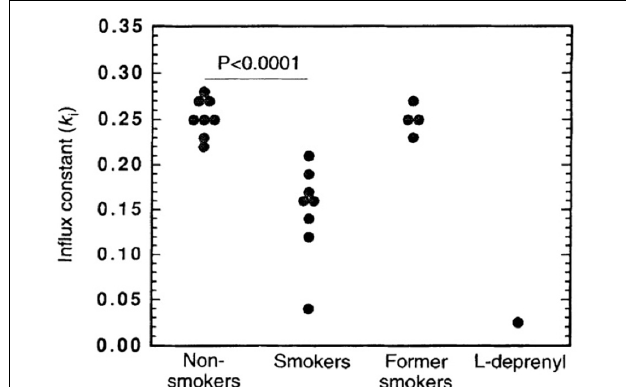
FIGURE 5 | Significantly lower monoamine oxidase B (MAO-B) in smokers ( n = 8) compared with non-smokers ( n = 8) and former smokers ( n = 4) as indicated by the effect on the influx rate constant (k i ) for the basal ganglia. As a reference, data for one control that was given a therapeutic dose of the monoamine oxidase inhibitor, L-deprenyl (10 mgd - 1 ), for 1 week is included. Adapted with permission from Fowler et al. (1996a). Copyright © (1996) Nature Publishing